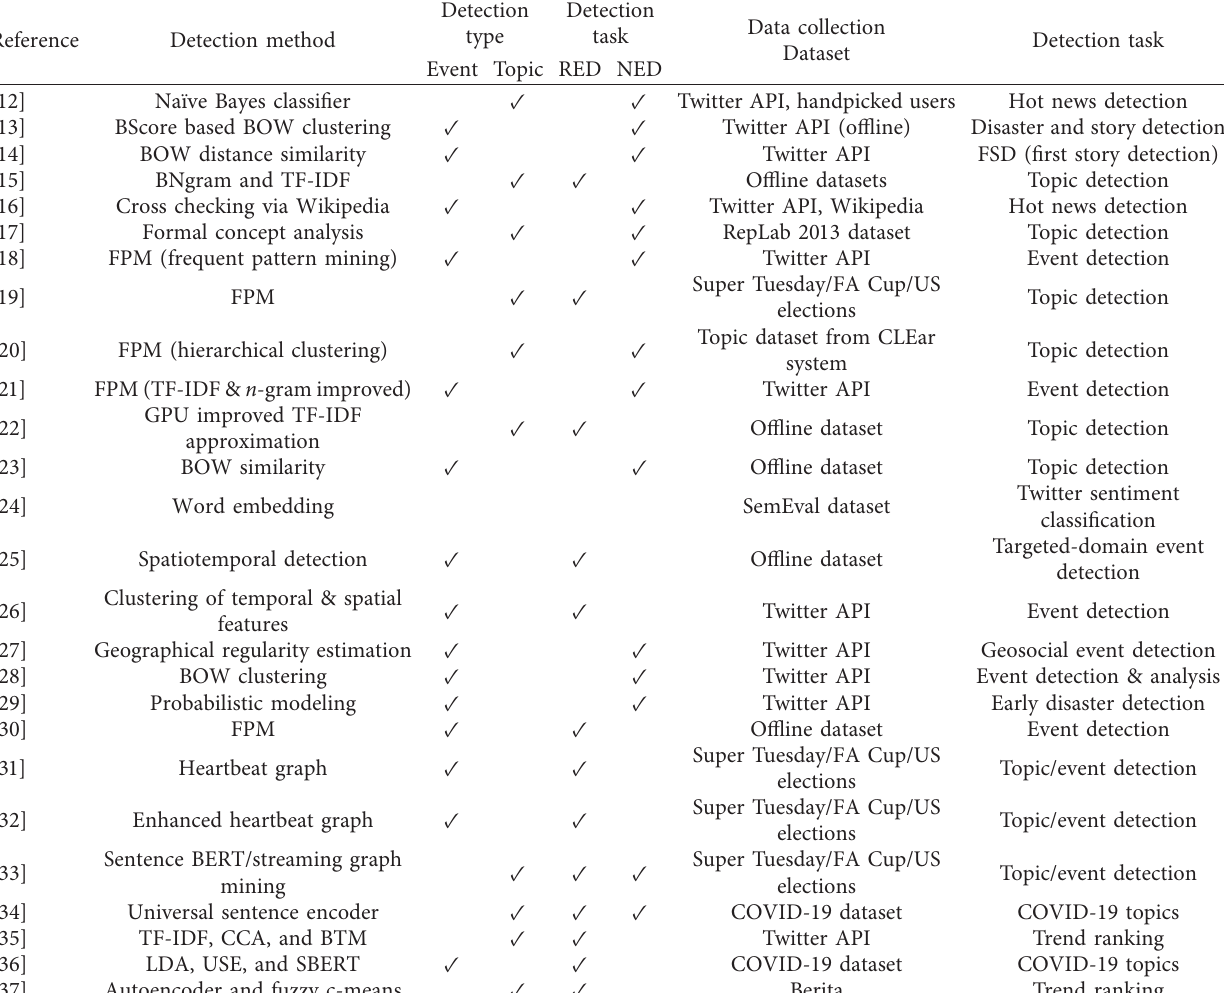
Table 1: Twitter topic/event detection/tracking related